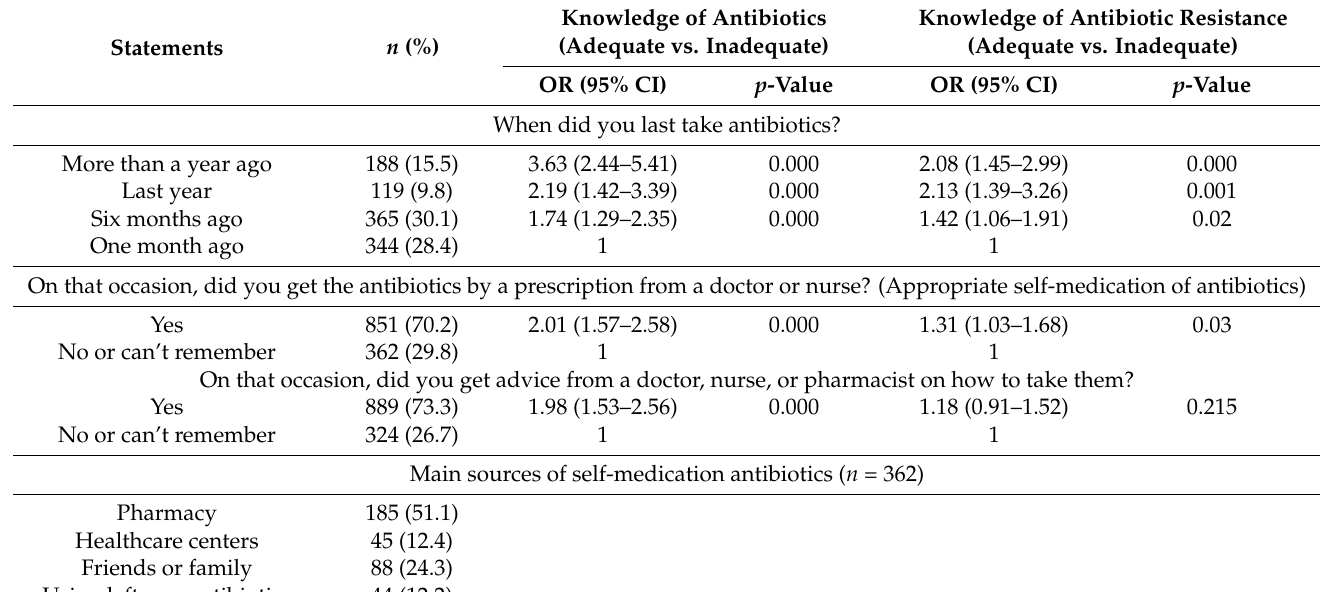
Table 4. Logistic regression of pattern of antibiotic usage associated with adequate knowledge of antibiotics and antibiotic